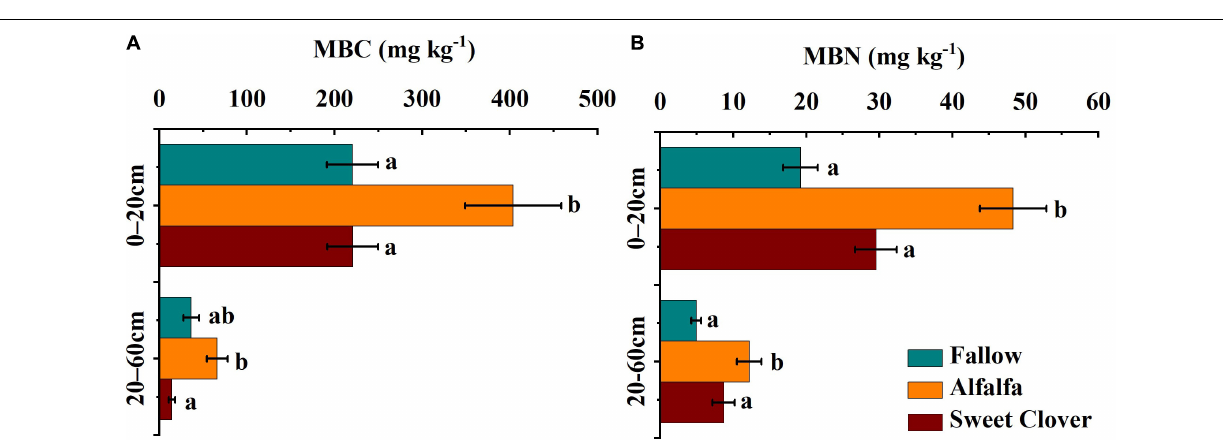
FIGURE 3 | MBC (A) , and MBN (B) distributions at different soil depths under different revegetation methods in 2019 (17 years after revegetation). Data represents the mean value ± standard error ( n = 9), and the different letters indicate significant differences at the p < 0.05 level. (MBC, microbial biomass carbon; MBN, microbial biomass